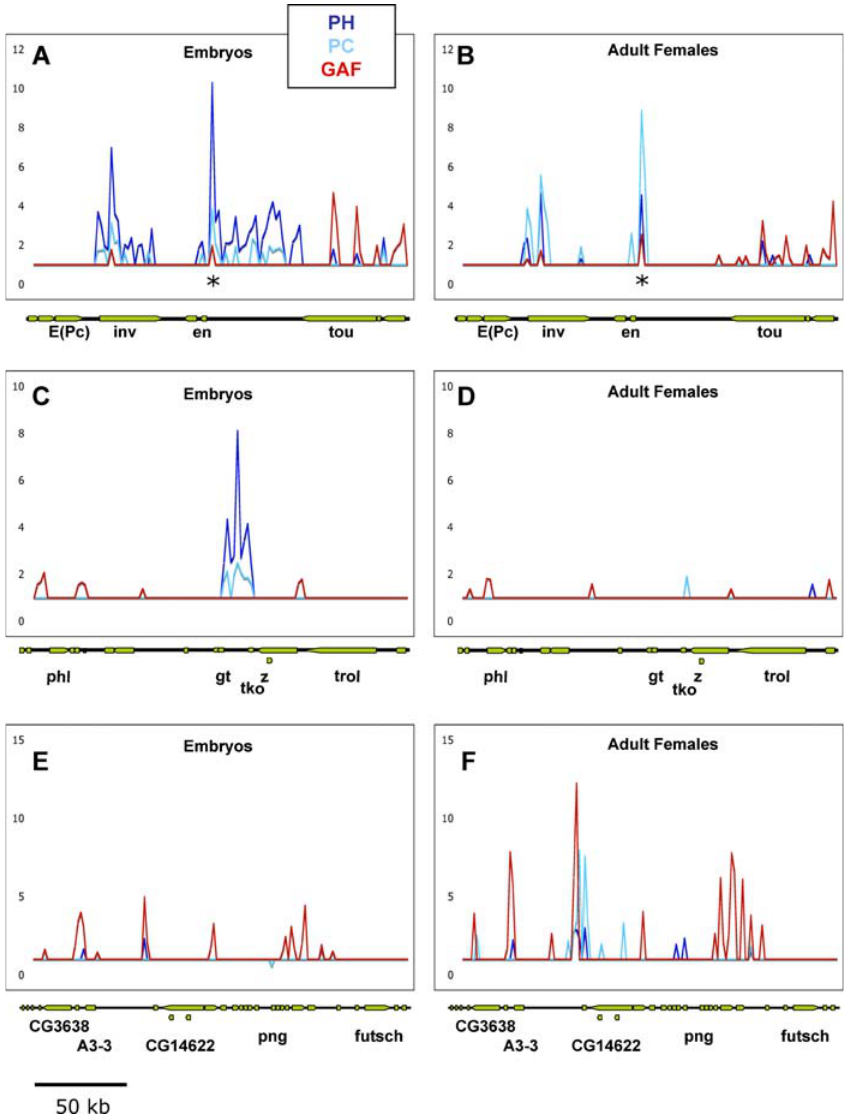
Figure 5. High Resolution Distribution Profiles GAF profiles are in red, PH in blue, and PC in light blue. Only significantly enriched signals detected by RDAM at a FDR of 10% are represented. Above each graph, the annotated genes of each genome region are shown. (A) Distribution profiles of PC, PH, and GAF in the en / inv locus at the embryonic stage. (B) Distribution of PC, PH, and GAF in the en / inv locus at the adult stage (females). The en PRE used as positive control is indicated by an asterisk. (C) Distribution of PC, PH, and GAF in the gt / z locus at the embryonic stage. (D) Distribution of PC, PH, and GAF in the gt / z locus in adult females. Note the disappearance of a strong PcG binding site, while GAF remains stable. (E) Distribution of PC, PH, and GAF in the futsch locus in embryos. (F) PC, PH, and GAF in the futsch locus in adult females. Note that a new binding site for PcG that was absent at the embryonic stage appears at the adult stage, while GAF remains stable. DOI: